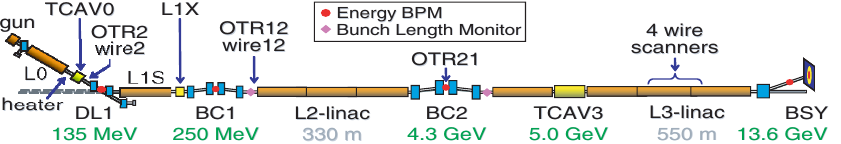
FIG. 1. (Color) LCLS accelerator layout showing BC1, BC2, both transverse rf cavities (TCAV0 and TCAV3), and screen at end of linac. The laser heater has not been installed for the experiments described in this paper.